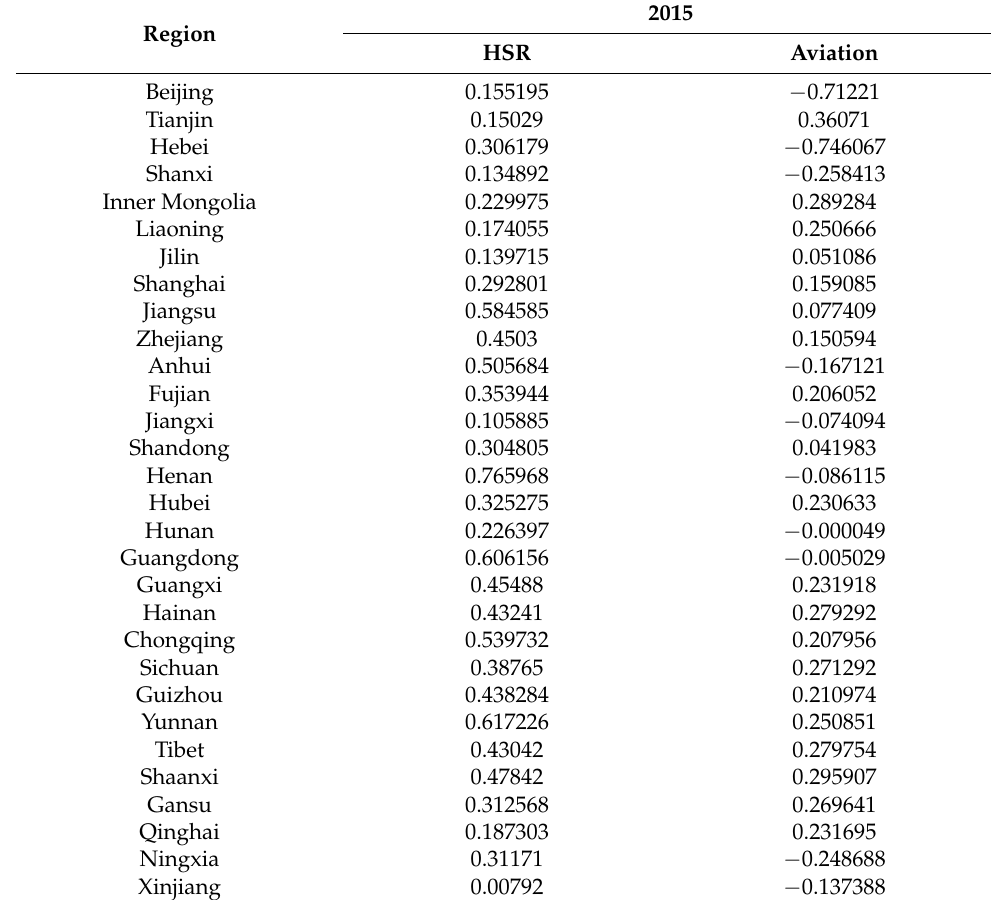
Table A3. GWPR Results of HSR and Aviation in